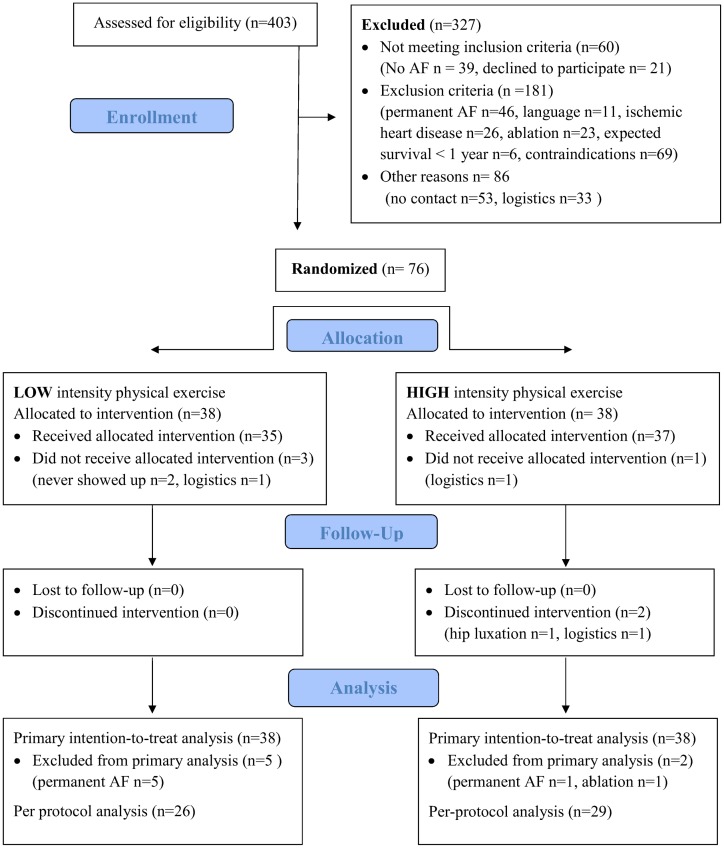
Patient flow diagram for low and high intensity physical exercise.